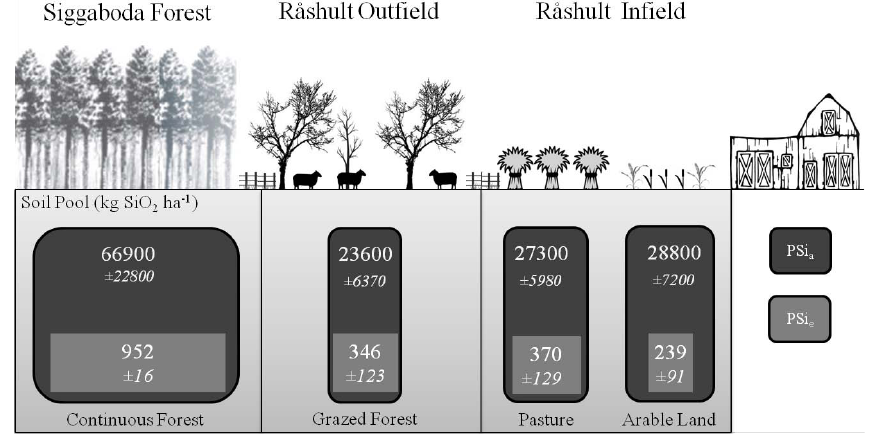
Fig. 1. Representation of the land use sequence in the study area, southern Sweden. Values indicate measured means ( ± standard errors) for total amorphous silica pool (PSi a ) and easily soluble silica pool (PSi e ) in the